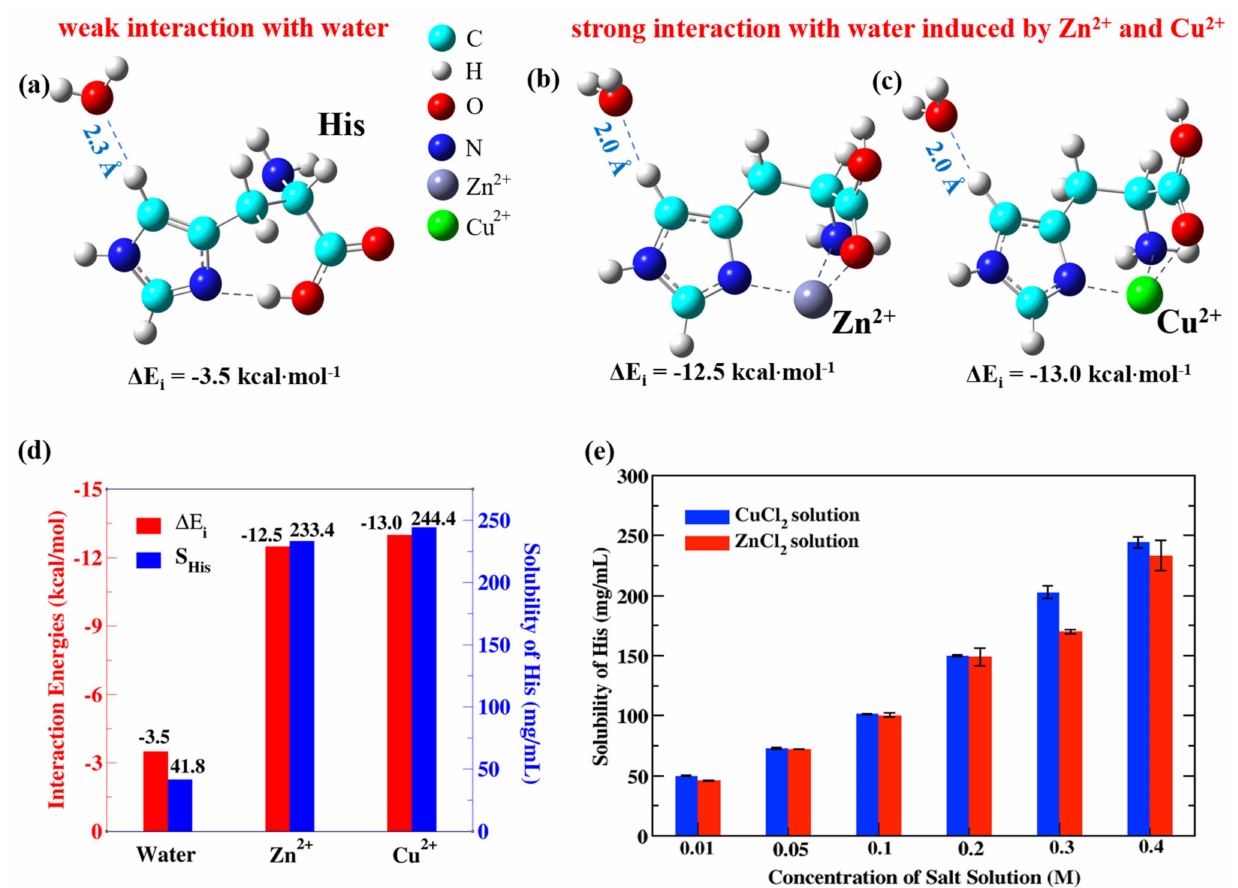
Figure 1. Interaction energies between His, Zn 2+ –His, Cu 2+ –His and the nearest water and the solubilities of His in ZnCl 2 and CuCl 2 solutions. ( a – c ) Optimized geometric structures of the His– water, Zn 2+ –His–water, and Cu 2+ –His–water systems and the interaction energies between the imidazole rings and the nearest water molecules. ( a ) Optimized distance between the imidazole ring in His and the nearest water molecule is 2.3 Å, and the interaction energy between them is − 3.5 kcal · mol − 1 . ( b ) Optimized distance between the imidazole ring and the nearest water molecule after Zn 2+ binding decreases to 2.0 Å, and the interaction energy increases to − 12.5 kcal · mol − 1 . ( c ) Optimized distance between the imidazole ring in His and the nearest water molecule after Cu 2+ binding decreases to 2.0 Å, and the interaction energy increases to − 13.0 kcal · mol − 1 . ( d ) Interaction energies ( ∆ E i ) between the imidazole ring in His and the nearest water molecule, without binding to any metal ion, with Zn 2+ binding, and with Cu 2+ binding and the solubilities of His (S His ) in pure water, 0.4 M ZnCl 2 solution, and 0.4 M CuCl 2 solution. ( e ) Solubilities of His in CuCl 2 and ZnCl 2